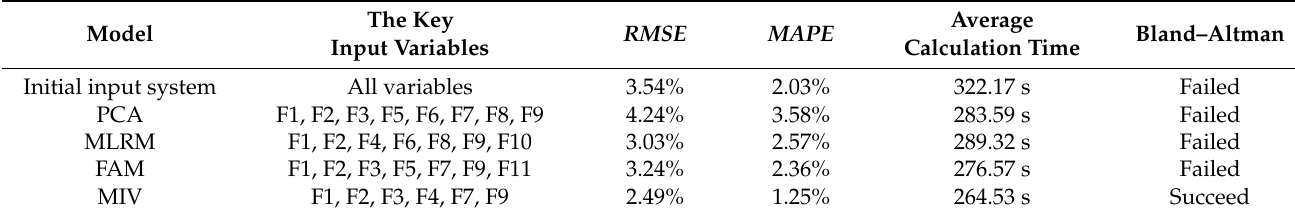
Table 16. Calculation results of different key index screening